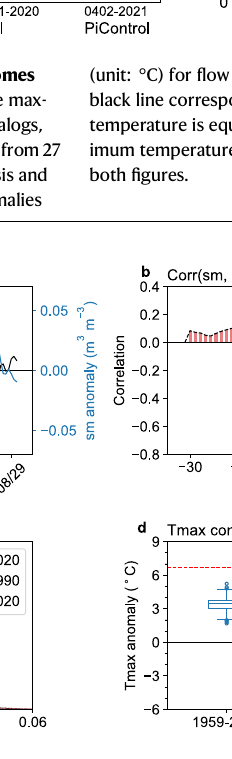
moistureanomalies(unit:m 3 m − 3 )underasimilarcirculationof27June – 3July2021, and the dashed curves denote the soil moisture anomalies for randomly picked days. The dashed vertical line indicates the soil moisture from 27 June – 3 July 2021. d The distribution of the maximum temperature anomalies (detrend, unit: °C) for analogs days generated using detrended soil moisture anomalies from 27 June – 3 July2021 during 1959 – 2020,1959 – 1990,and 1991 – 2020. The red line indicates